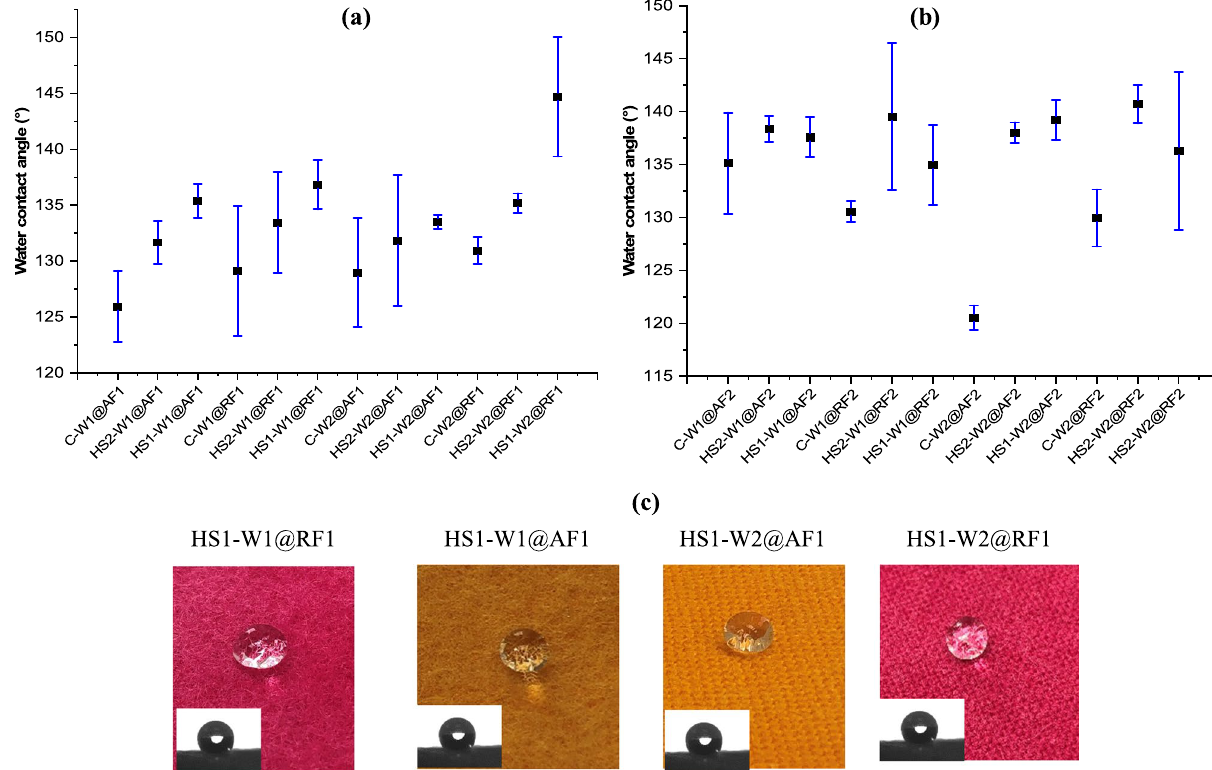
Figure 5. Water contact angle analysis of hydrophobic finished wool fabrics; ( a ) Ruco-Dry ECO DCF (F1); ( b ) Ruco-Dry DHE (F2) and ( c ) digital picture of hydrophobicity of wool